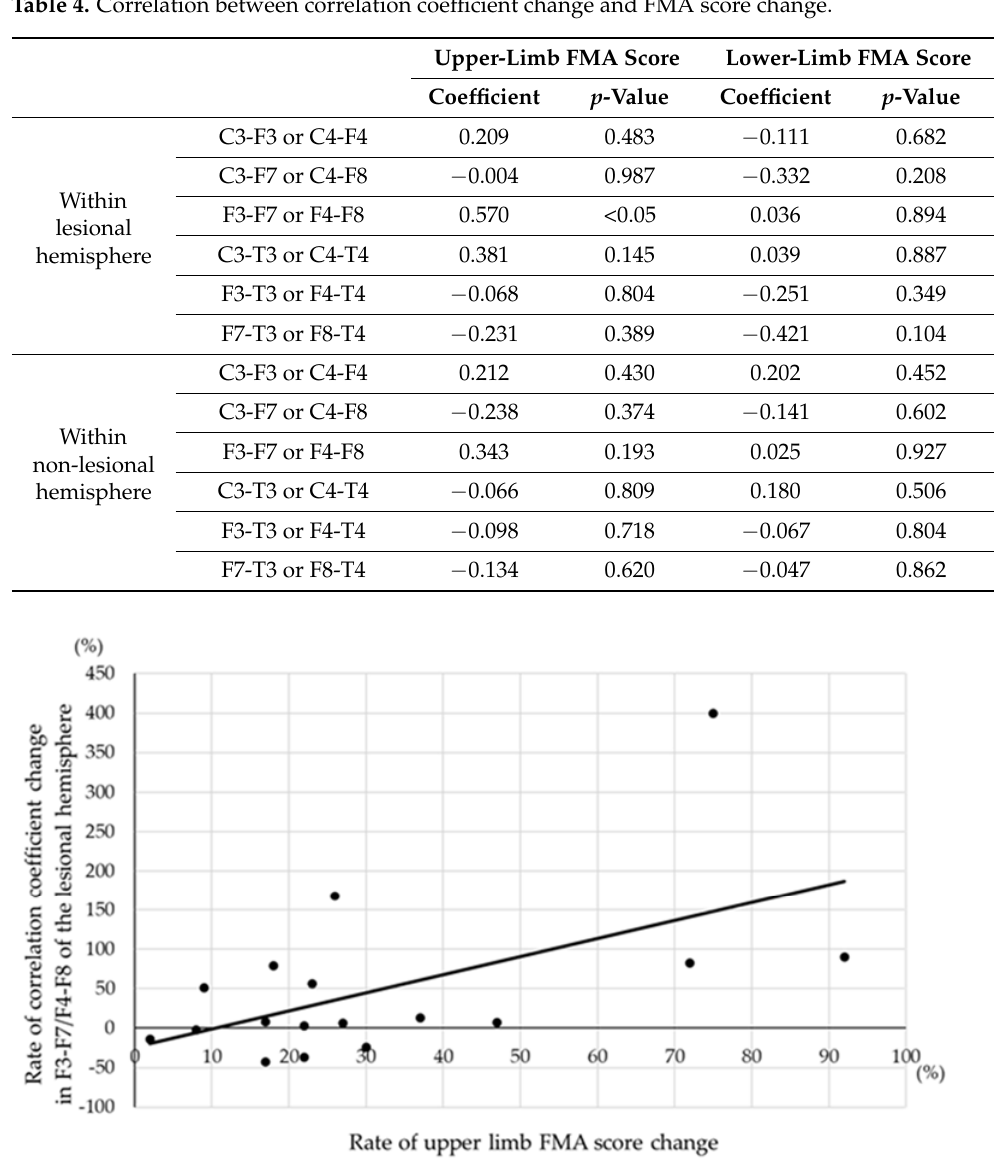
Figure 2. Scatter plots showing significant correlation between rate of correlation coefficient change